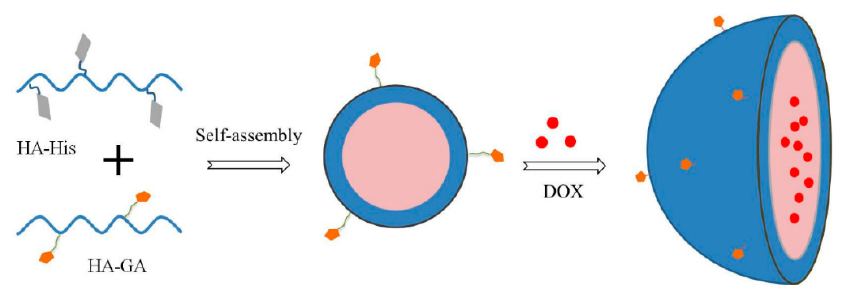
Figure 4. Preparation of DOX-loaded micelles (Reprinted with permission from Ref. [63]. 2016, Jing-Liang Wu).